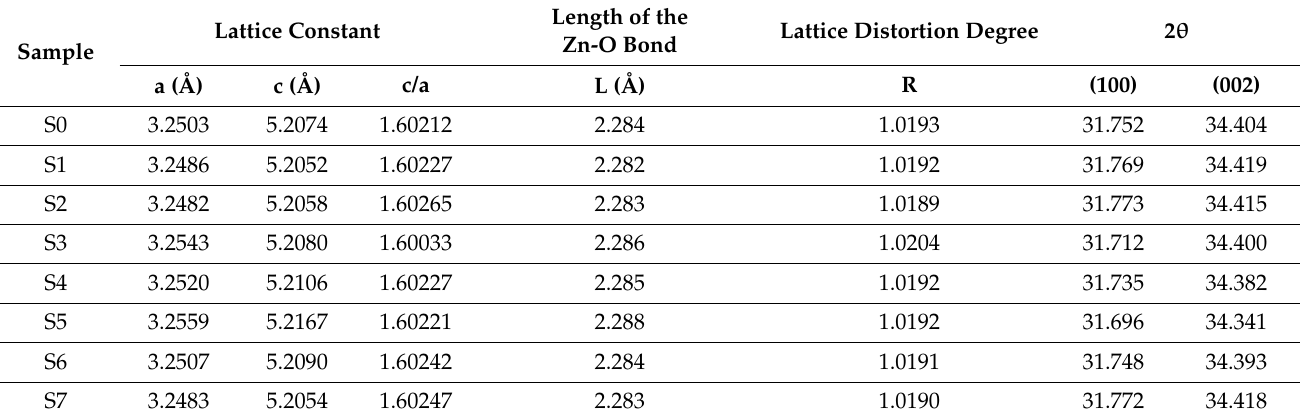
Table 2. Structural parameters of the pure and B-doped ZnO thin